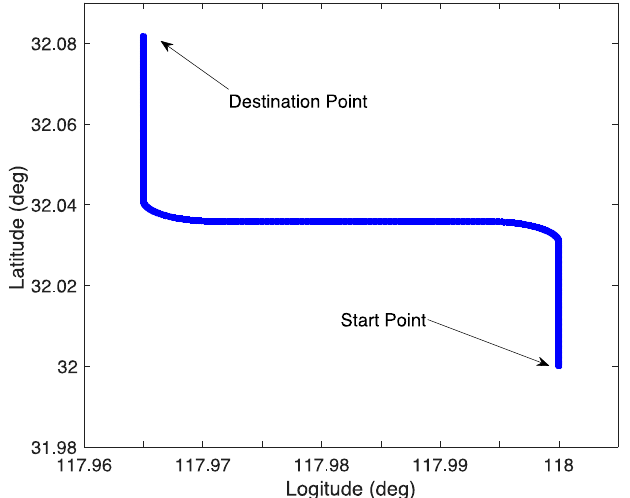
Figure 1. The in-motion trajectory of the vehicle.